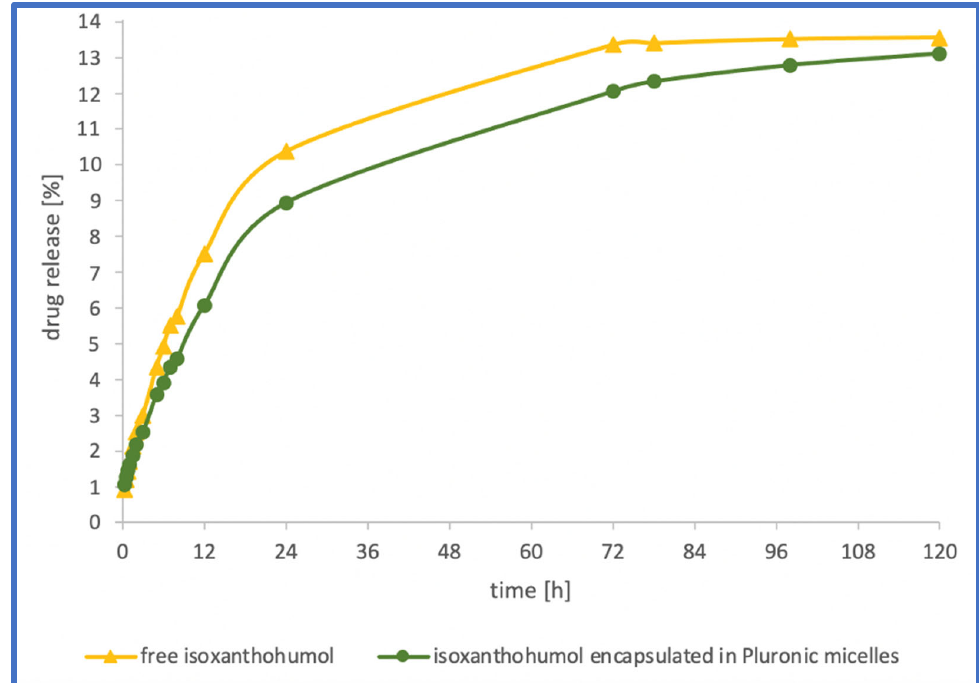
Figure 6. In vitro release profile of isoxanthohumol ‐ loaded P123/F127 Pluronic micelles (ratio 1:5) and free isoxanthohumol.